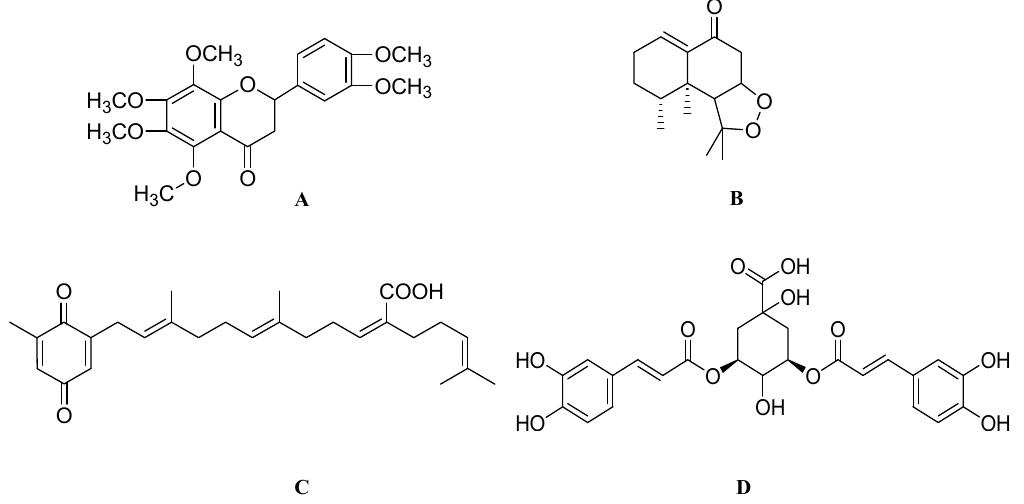
Figure 6. The molecular structures of nobiletin ( A ), nardosinone ( B ), sargaquinoic acid ( C ) and ( − )-3,5-dicaffeoyl-muco-quinic acid ( D